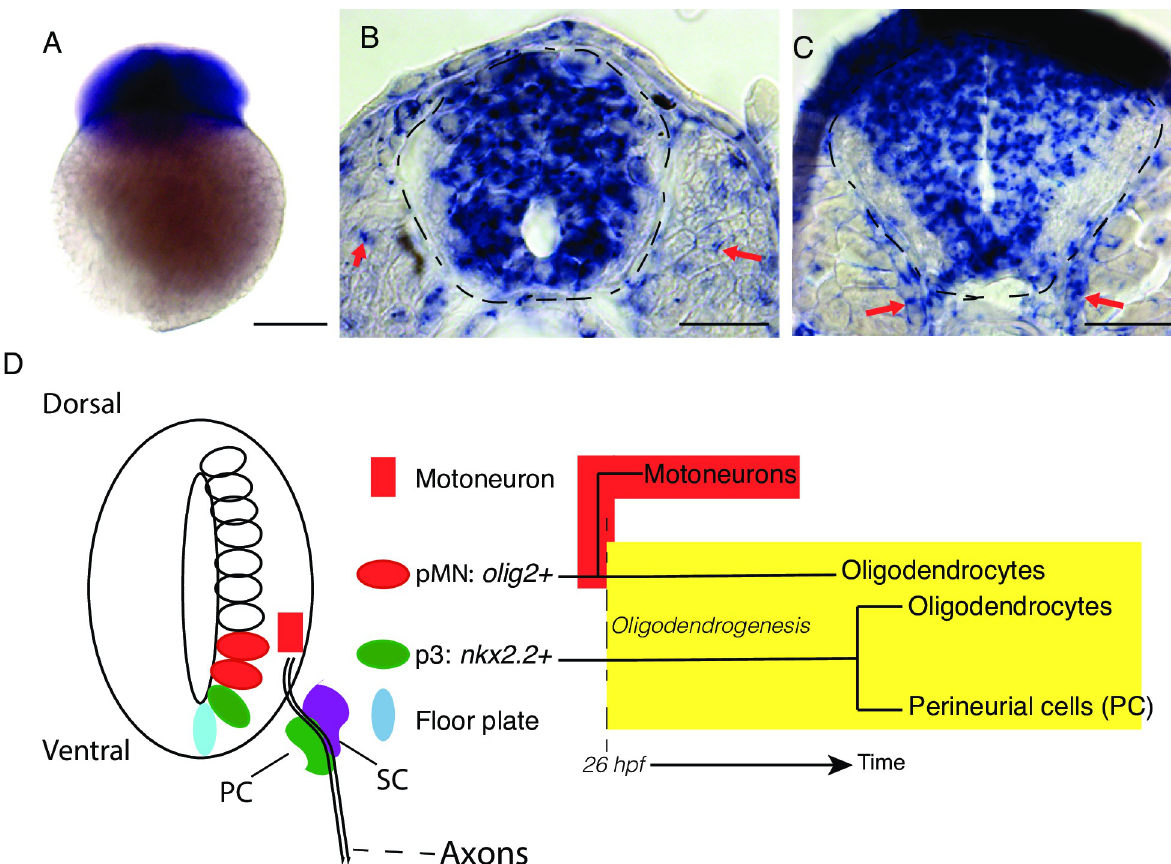
Fig 2. YPEL3 is an evolutionarily conserved disease-causing candidate gene. ( A-C ) ypel3 is maternally deposited and expressed during neural development in zebrafish. ( A ) Two-cell stage embryo. ( B-C ) Transverse sections. ( B ) At 24 hours postfertilization (hpf), ypel3 is expressed broadly in the spinal cord and sparsely in the somites (red arrows). ( C ) At 56 hpf, ypel3 is expressed in the spinal cord and in the region where the motor roots develop (red arrows). (D ) Diagram of spinal cord domains, their derivatives, and molecular markers. The pMN domain ( olig 2+ ) gives rise first to motoneurons, and then later oligodendrocytes (Briscoe et al., 2000; Jessell, 2000; Danesin and Soula, 2017). The p3 domain ( nkx2 . 2+ ) is localized ventral to the pMN domain and gives rise to oligodendrocytes and a subset of perineurial cells (Clark et al., 2014; Kucenas et al., 2008b). Schwann cells (SC) are neural crest derivatives. Scale bar: 250 μ m in A , 25 μ m in B and C .